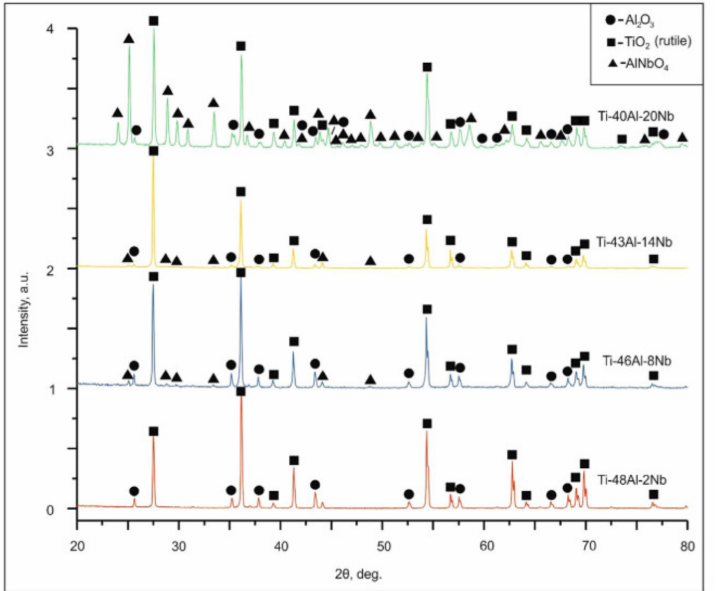
Figure 7. Diffractograms after oxidation at 900 ◦ C. The position of peaks relating to Al 2 O 3 , TiO 2 (rutile) and AINbO 4 oxide phases are indicated. Reprinted from Materials Characterization, 163,